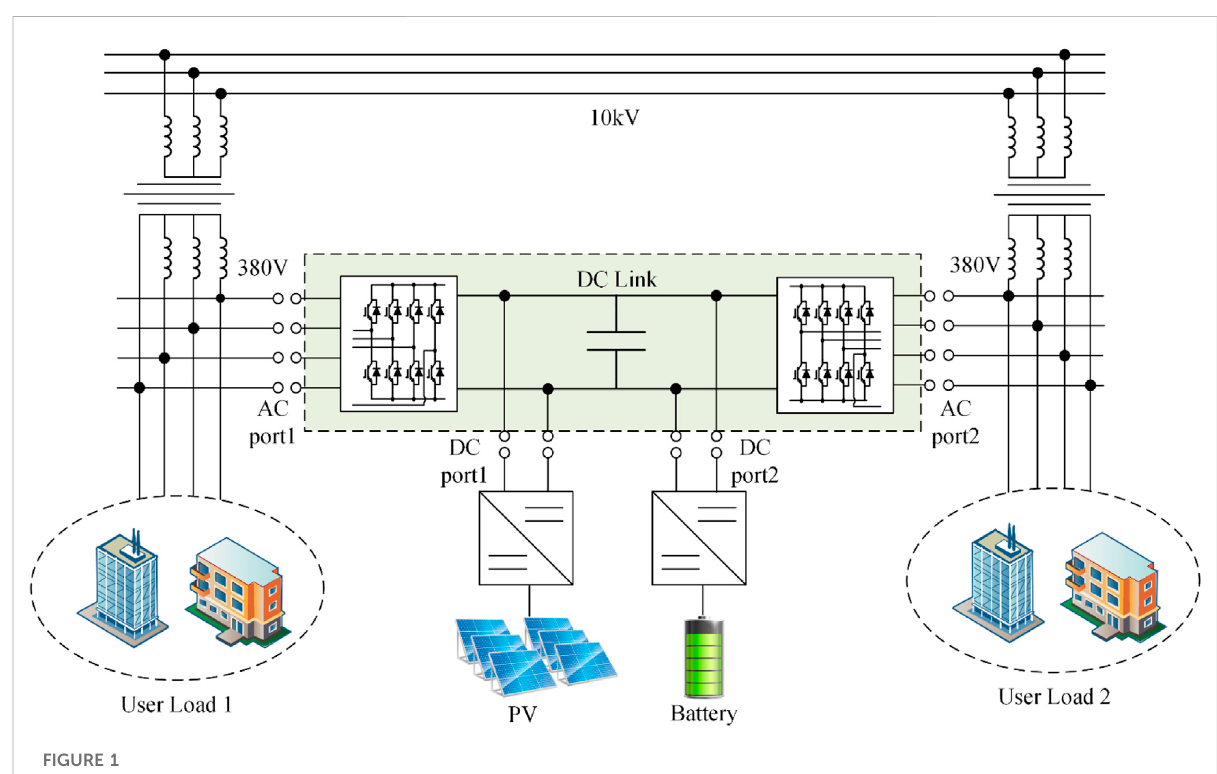
FIGURE 1 Distribution network system with